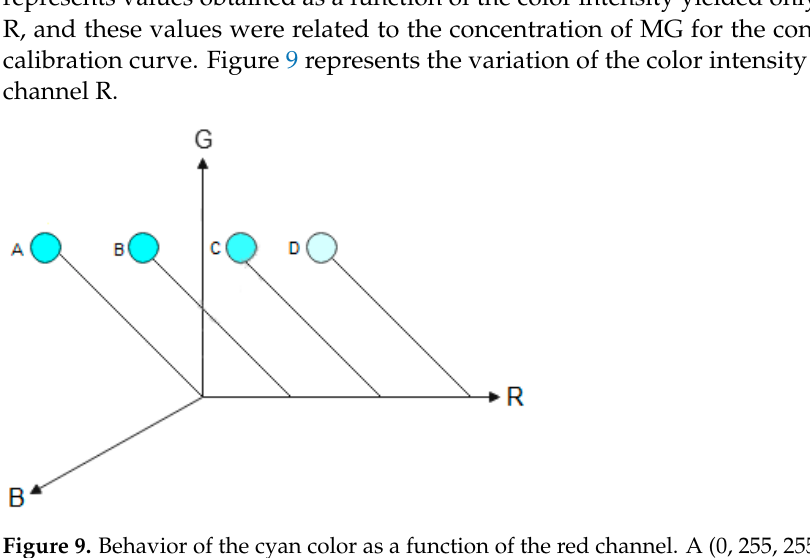
Figure 8. Isotherms for the process of adsorption of MG to polyimide nanofiber. Langmuir model ( a ). Freundlich model ( b ). Using 2.0 mg of adsorbent at 20 °C.